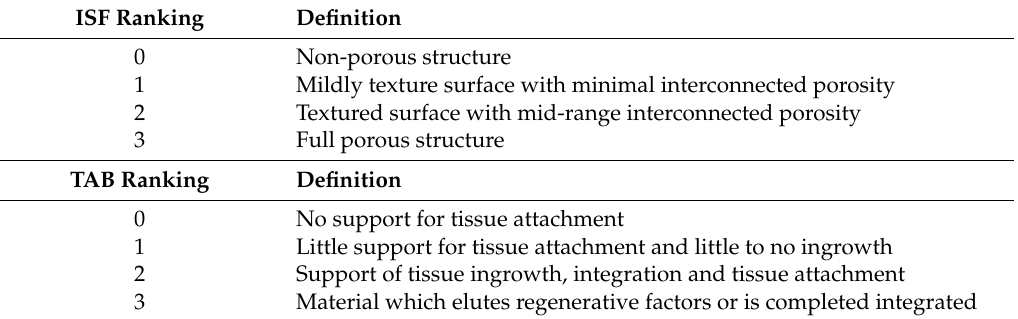
Table 1. Definition of interactive surface form (ISF) and tissue attachment bioactivity (TAB) rankings. ISF Ranking